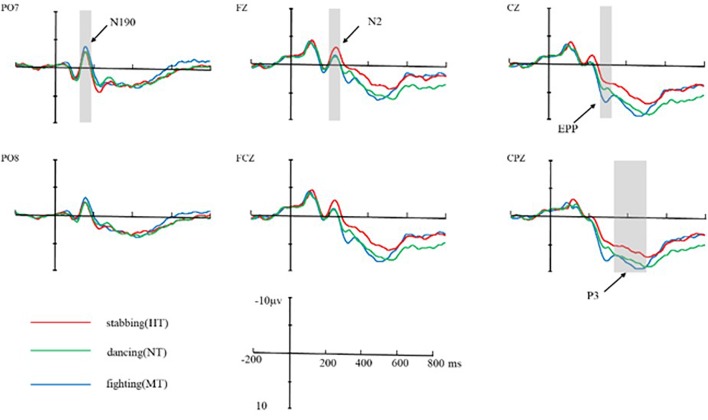
Average ERPs at Fz, FCZ, CZ, CPZ, PO7, and PO8 for HT, MT, and NT conditions. The neural activation (waves from at PO7 and PO8 for N190, Fz, FCZ for N2, CZ for EPP, and CPZ for P3) in contrast of HT condition, MT condition, and NT condition. Under N2 component, HT amplitude was larger than MT and NT; under EPP component, MT amplitude was larger than NT and HT.